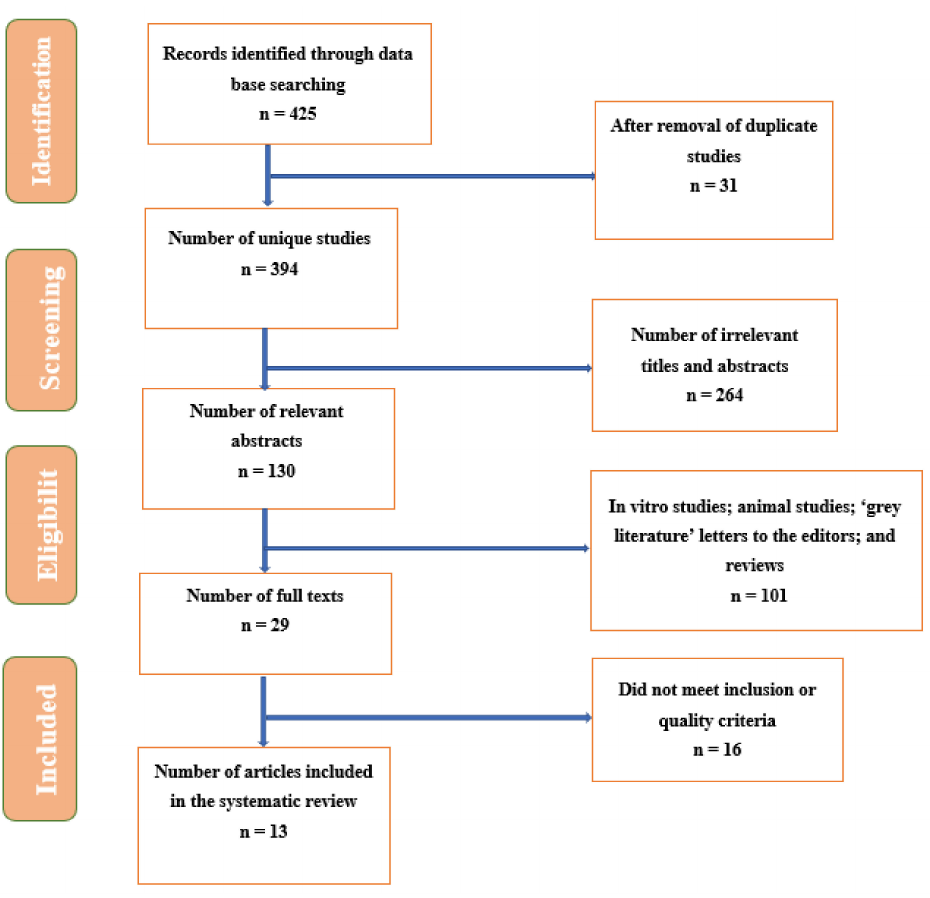
Figure 1. Flowchart summarizing the identification and selection of papers for systematic